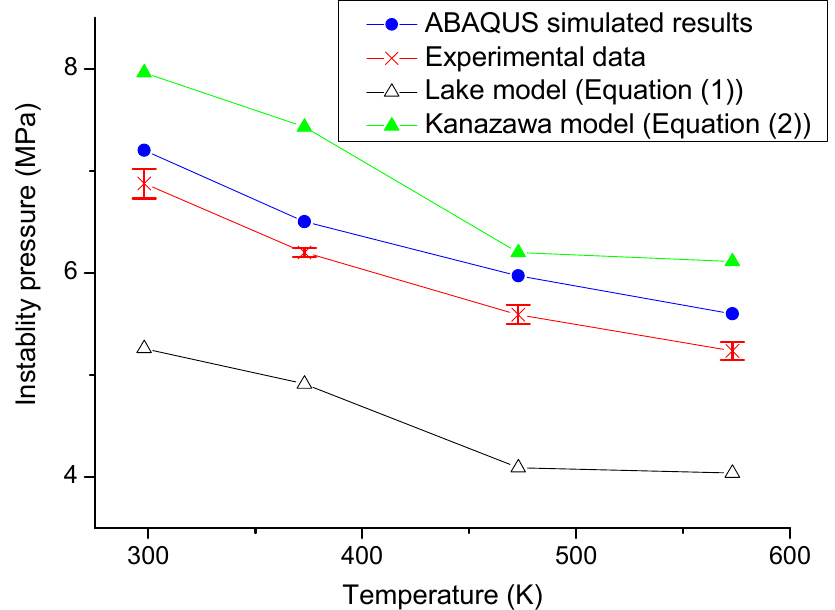
Figure 10. The ultimate burst pressures as a function of temperature for the domed rupture discs. Calculated results using Equations (1) and (2) are integrated for comparison.